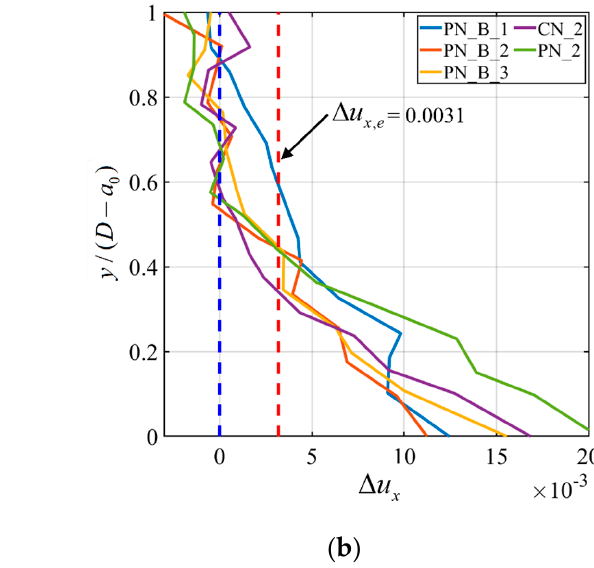
Figure 13. ( a ) ε xx profile for all specimens equipped with DIC considering only peak loads; and ( b ) Δ u x profile for all specimens equipped with DIC considering only peak loads. ( b ) ∆ u x profile for all specimens equipped with DIC considering only peak